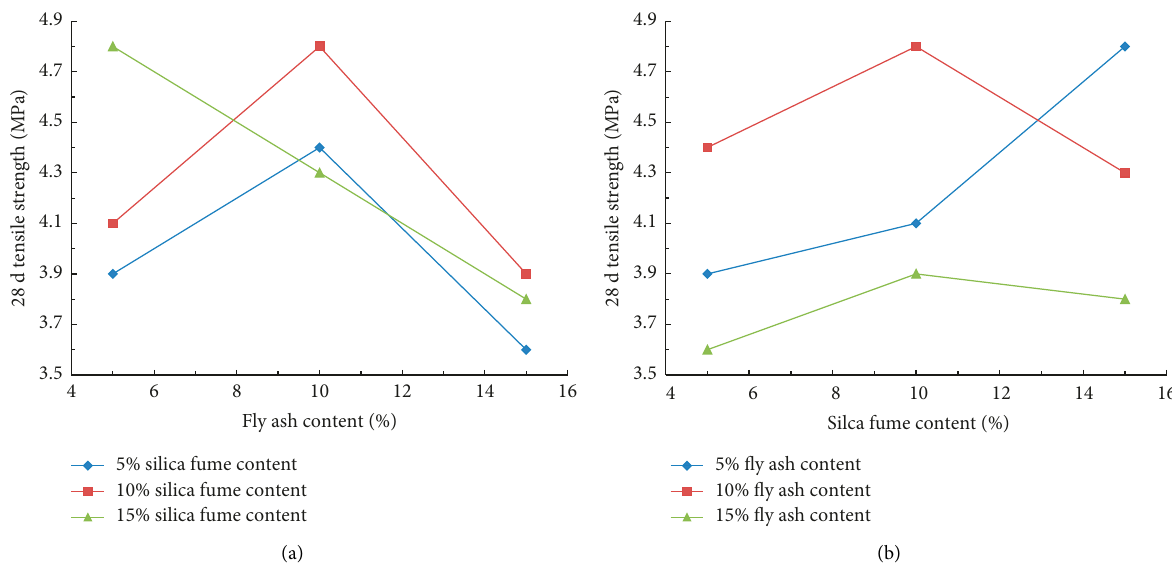
Figure 11: Influence of fly ash and silica fume on the tensile strength of MPPF coral concrete. (a) Influence of fly ash content on tensile strength of concrete splitting. (b) Influence of silica fume content on tensile strength of concrete